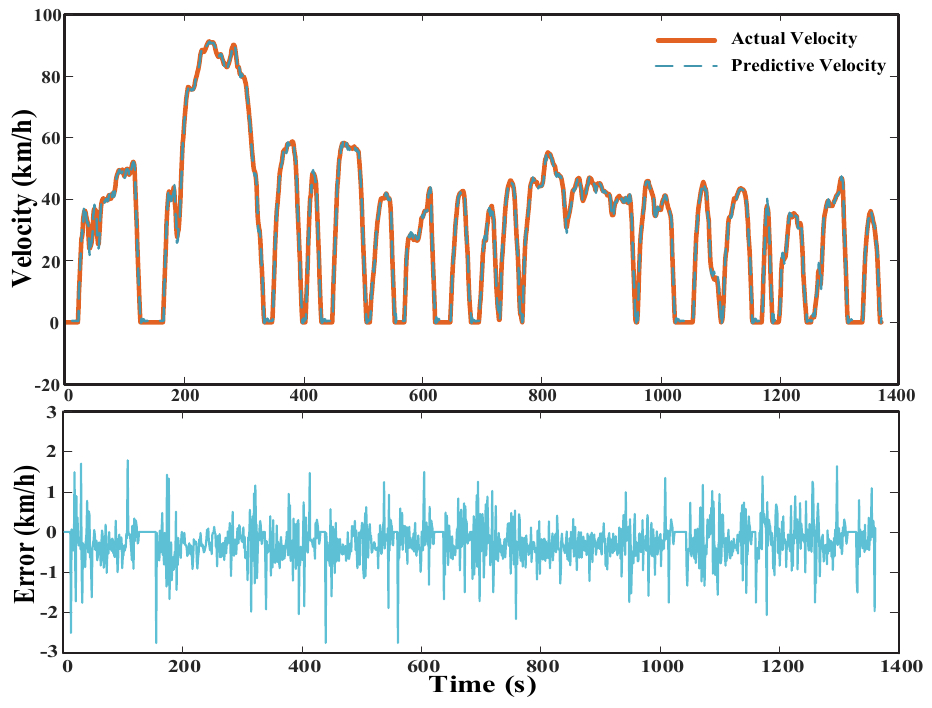
14 of 24 Figure 10. Flowchart of PSO − BP neural network velocity prediction algorithm. According to the above process, the PSO − BP neural network velocity prediction model was established, and then the urban dynamometer driving schedule (UDDS) stand- ard driving cycle was determined to verify the prediction effect of the model. Figure 11 shows the single − step prediction effect of the prediction model. It can be seen that the